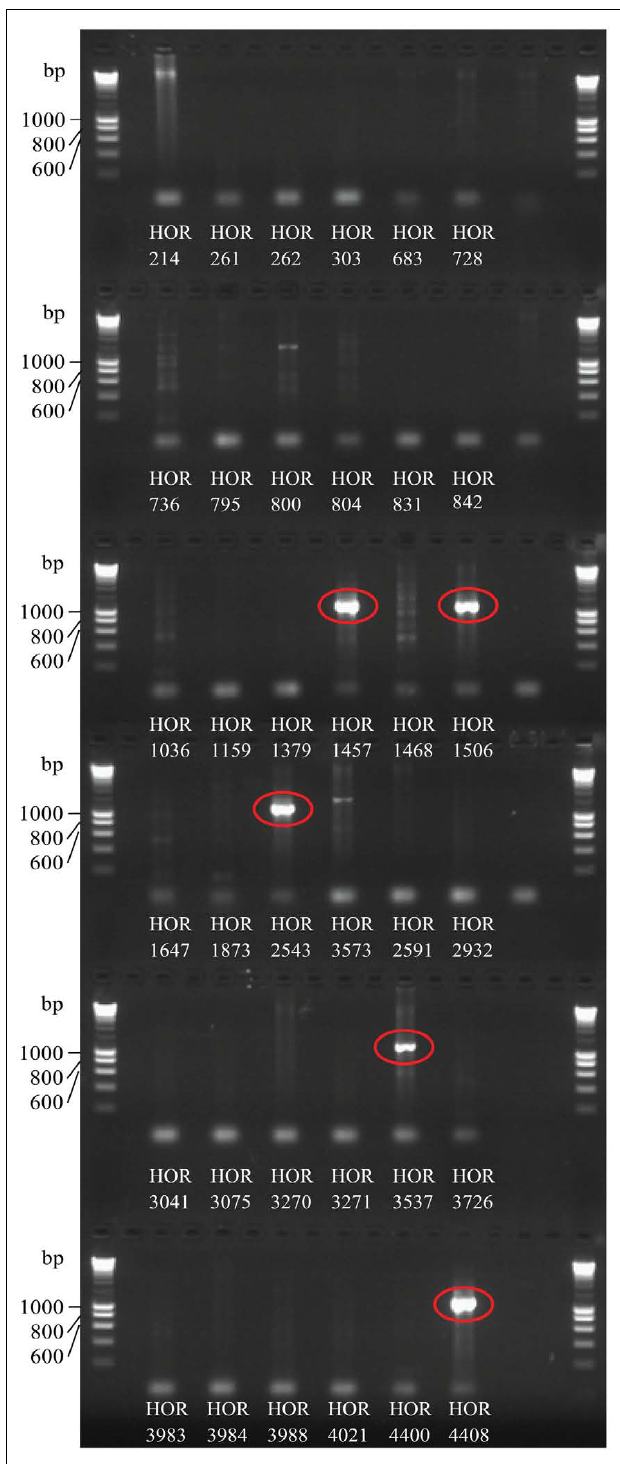
FIGUREA2 | Genotyping of resistant accessions for the presence of the mlo-11 allele mediating resistance to Bgh . Presence of mlo-11 results in a PCR fragment of 1100bp (dominant marker, highlighted by red